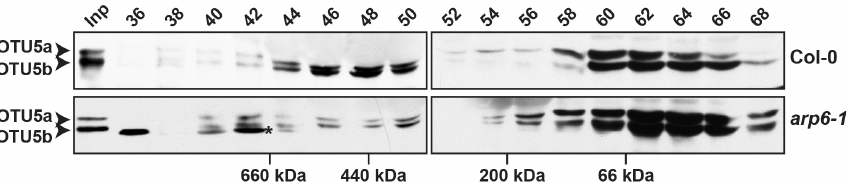
Figure 8. Size and abundance comparison of OTU5-associated complex(es) in wild-type and arp6-1 seedlings. The sizes and abundance of OTU5a- and OTU5b-associated complexes were examined by gel filtration experiments using protein extracts isolated from rosette leaves of three-week-old Col-0 and arp6-1 plants. The collected even-numbered fractions (36–68) were analyzed by SDS- PAGE followed by immunoblotting with α -OTU5 antibodies. The calibrated fraction positions of the molecular weight markers are shown at the bottom; the asterisk marks an unknown signal.